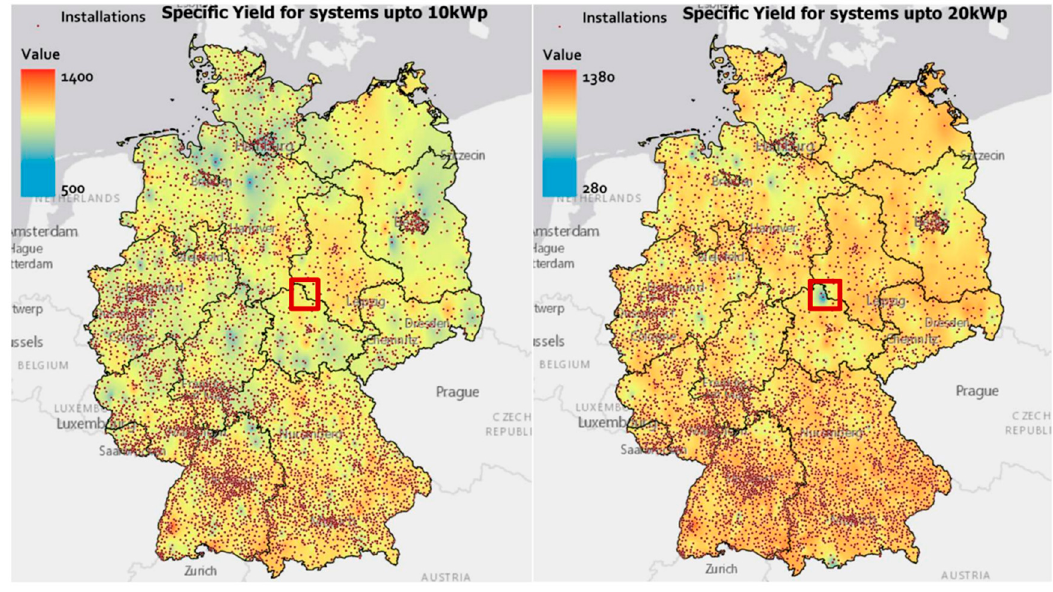
Figure 8. Specific yield variation from the installations in the Germany, for different system sizes.